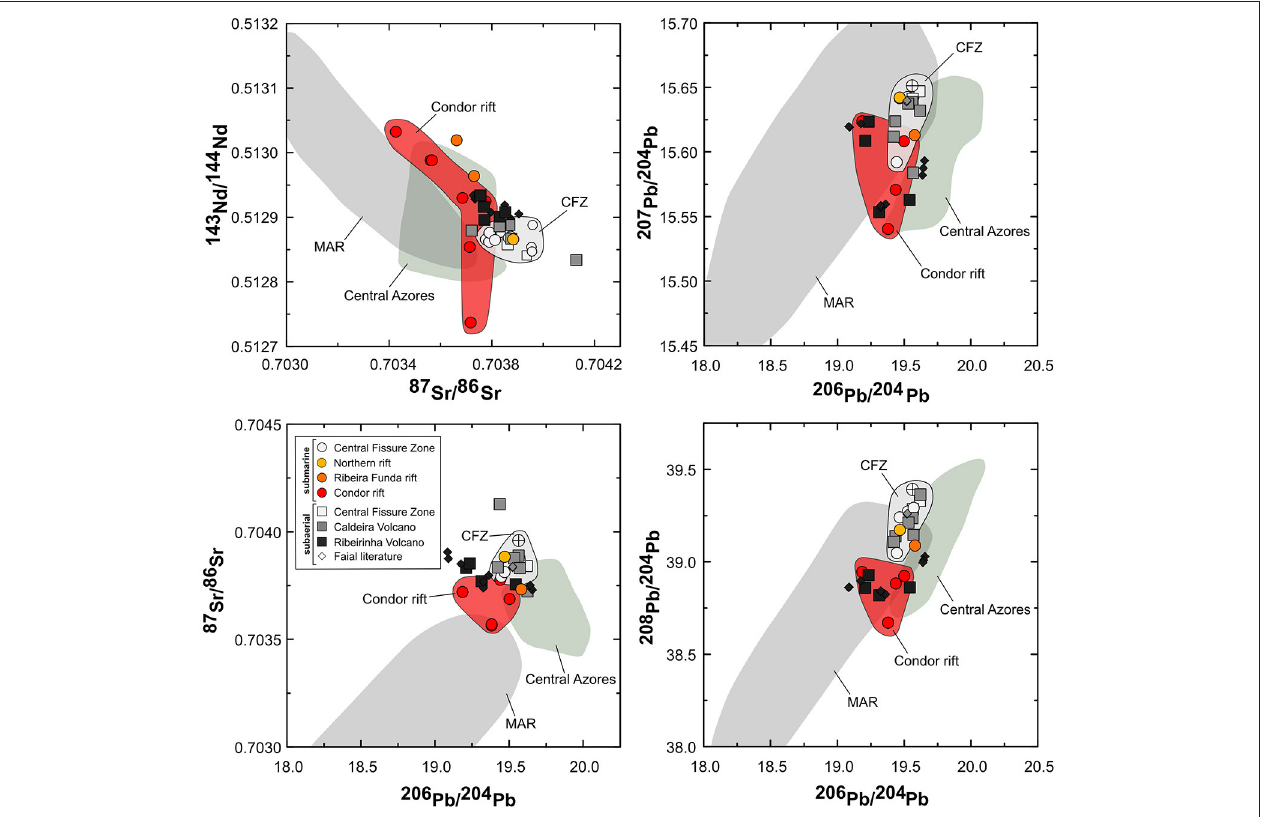
FIGURE 7 | Strontium-Nd-Pb isotope ratios of submarine and subaerial lavas from Faial. Green highlighted areas are samples from the Central Azores Plateau (São Jorge and Pico) from Hildenbrand et al. (2008), Beier et al. (2012), and Hildenbrand et al. (2014). Gray field are samples from the Mid-Atlantic-Ridge (MAR) from Dosso et al. (1999). CFZ, Central Fissure